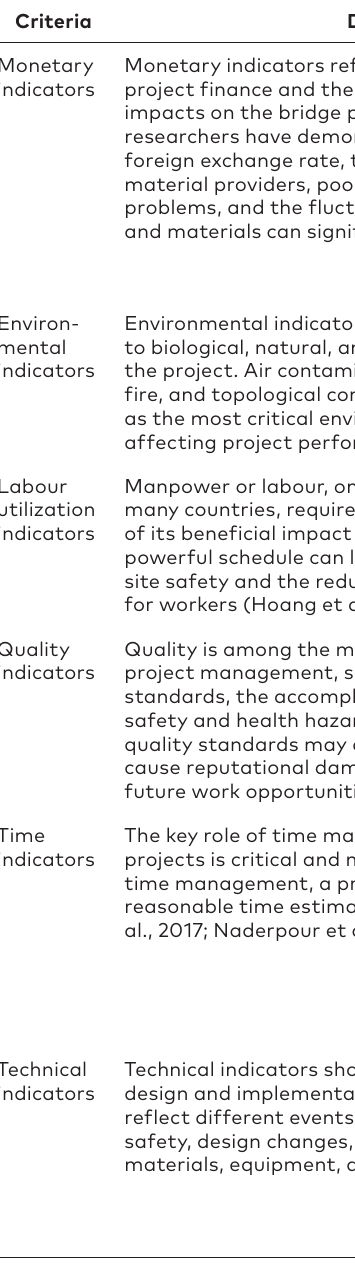
Table 1. Criteria and their